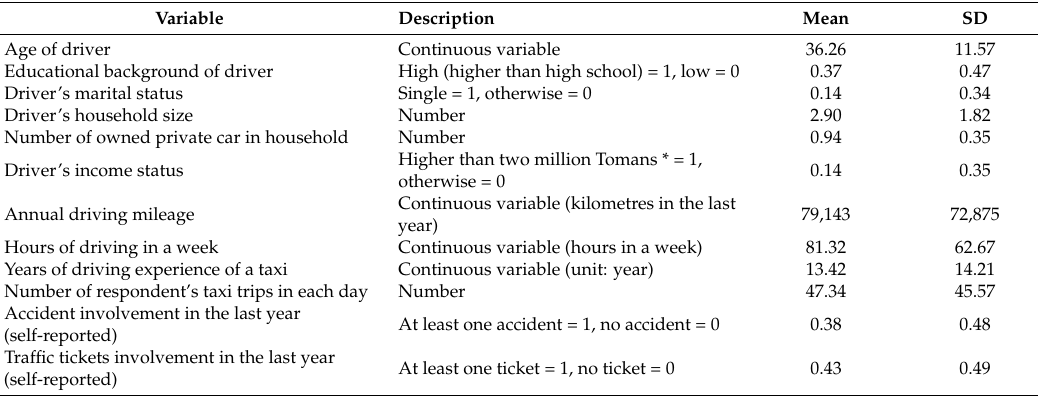
Descriptive statistics of the background variables and risk involvement ( n = 381). SD—standard